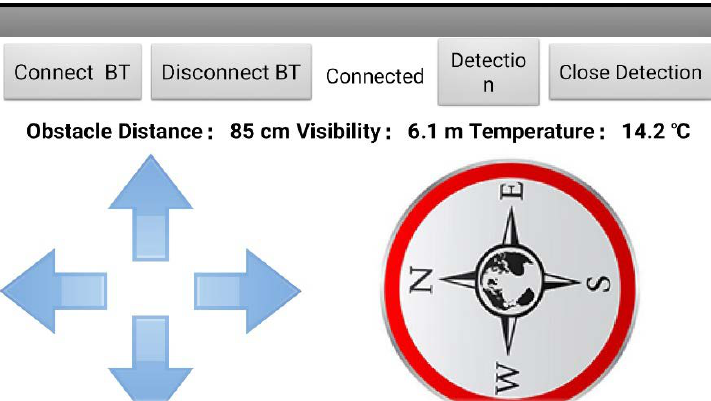
Figure 3. The interface of the remote control system.